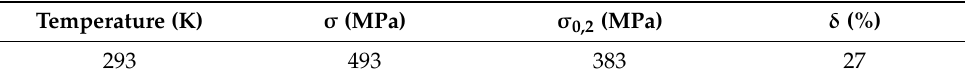
Table 8. Mechanical properties of NbStrip-1 foil.